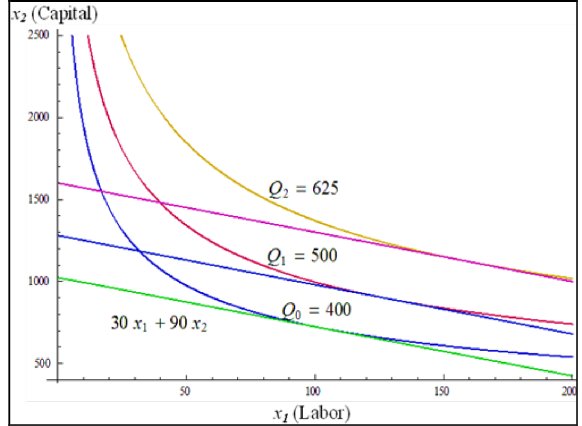
Fig. 3. A simple example of finding minimal activity cost using isocosts and